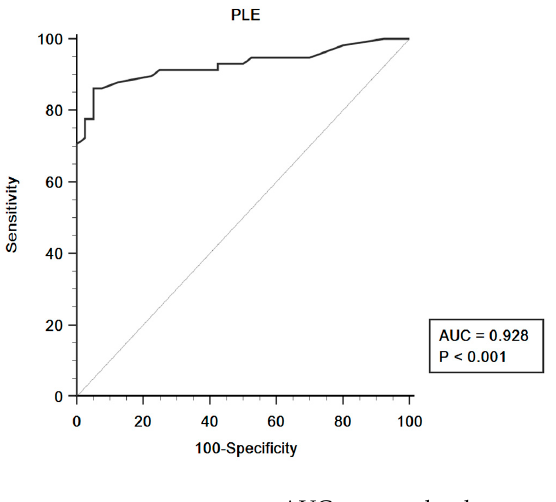
Figure 4 . Receiver operating characteristic curves of phase lag entropy . Figure 4. Receiver operating characteristic curves of phase lag